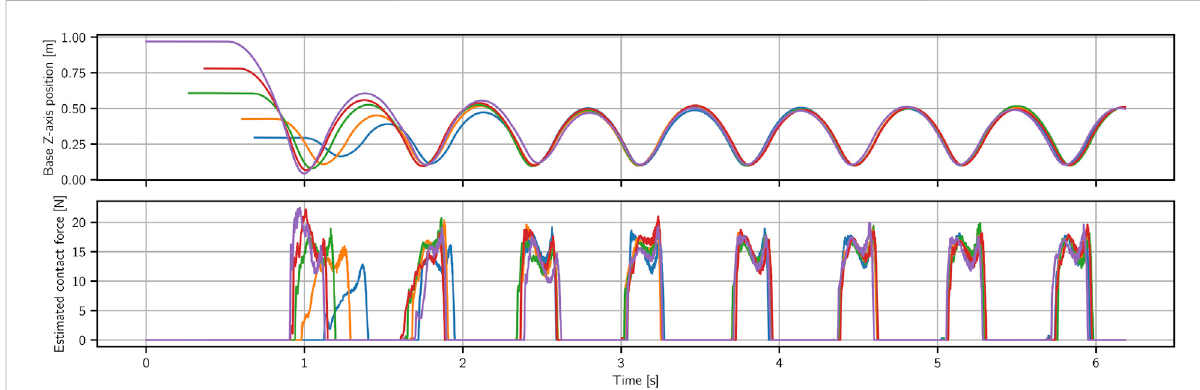
FIGURE 3 Hopping experiments started from different initial heights. The top fi gure shows that after dropping the robot from a set of different heights ranging between 0.3 and 1 m, the robot goes back to the nominal behavior of hopping at height of 0.5 m in one or at most two cycles. The bottom fi gureshowsthat,dropping fromdifferentinitial heights,therobotisabletoadaptitslandingsuchthattheimpactforcesremainverylow andalmost invisible in the estimated